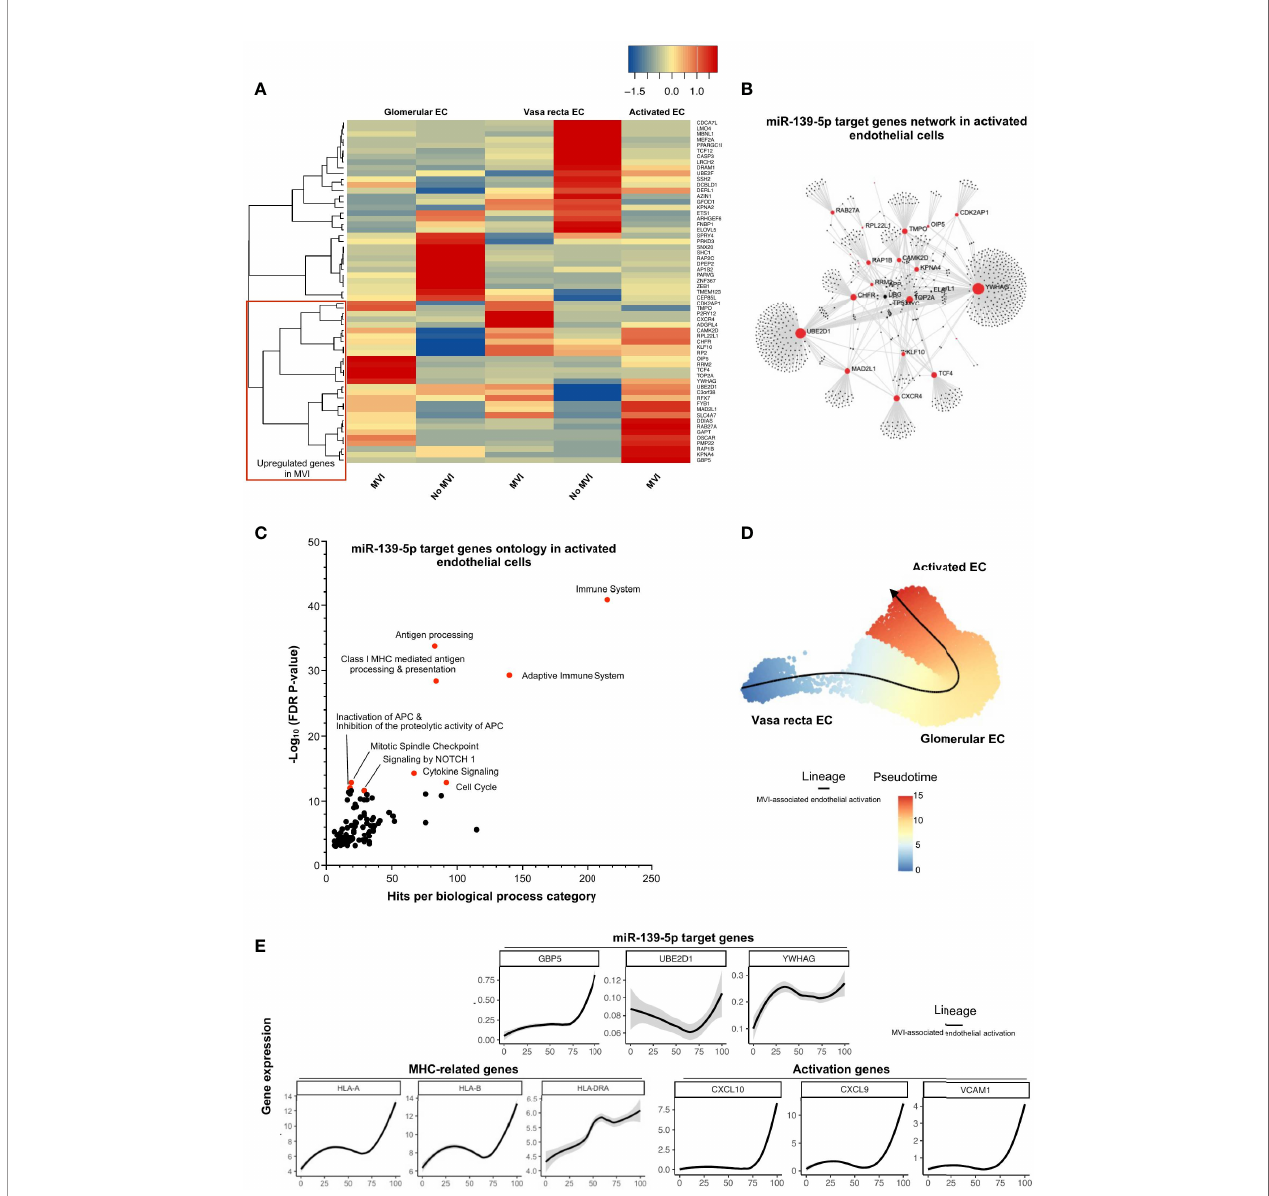
FIGURE 5 | miR-139-5p decrease leads to activation of EC and antigen-presentation pathway during MVI. (A) Heatmap showing the expression of each individual miR-139-5p target genes in the different endothelial cells (EC) subsets and according to the MVI groups. Red rectangle indicates upregulated genes in MVI. (B) Gene network corresponding to those 31 upregulated genes in MVI built on Omicsnet. (C) Gene ontology and pathway enrichment analysis based on Omicsnet and Reactome databases. The name of the top 10 enriched pathways in term of adjusted P-value are shown (red dots). (D, E) Pseudotime analysis. (D) Pseudotime trajectories for EC based on Slingshot R package, showing one lineage (MVI-associated EC activation). (E) Pro fi ling of genes along this trajectory to con fi rm their functional